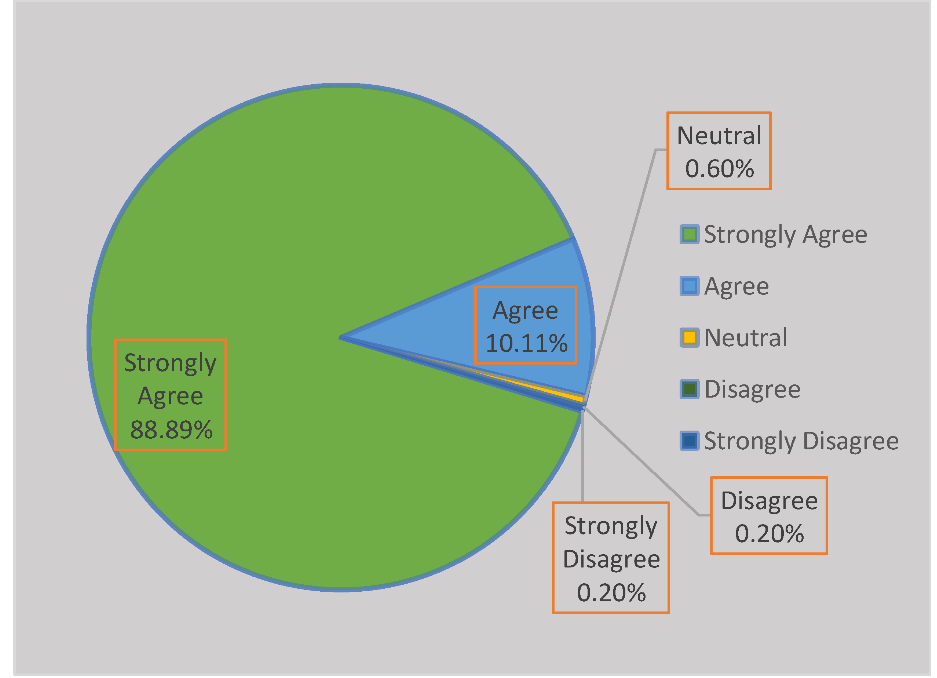
Figure 6. The illustration of how respondents understood the concept of solid waste management and how it can cause strong, unpleasant odour.